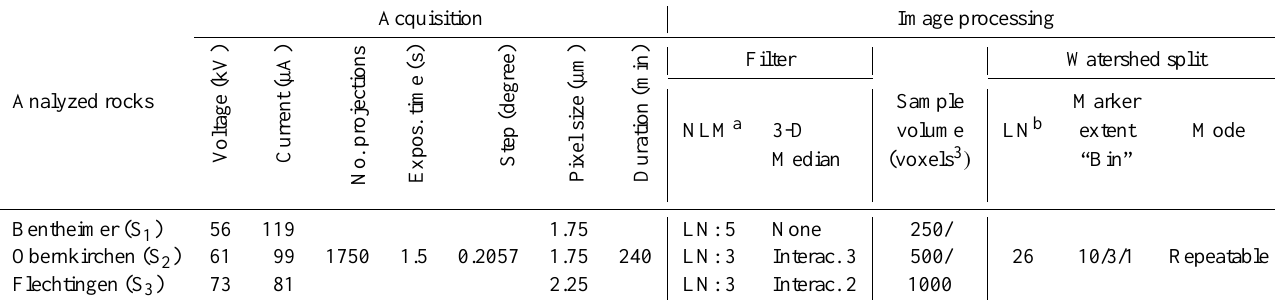
Table 2. 3-D x-ray µ-CT data acquisition and processing parameters for the analyzed rocks. Acquisition Image